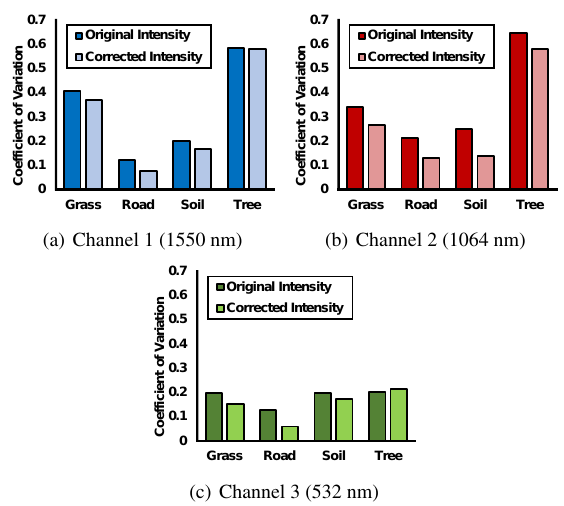
Figure 2. Coefficient of variation ( cv ) of four selected land cover samples before and after radiometric